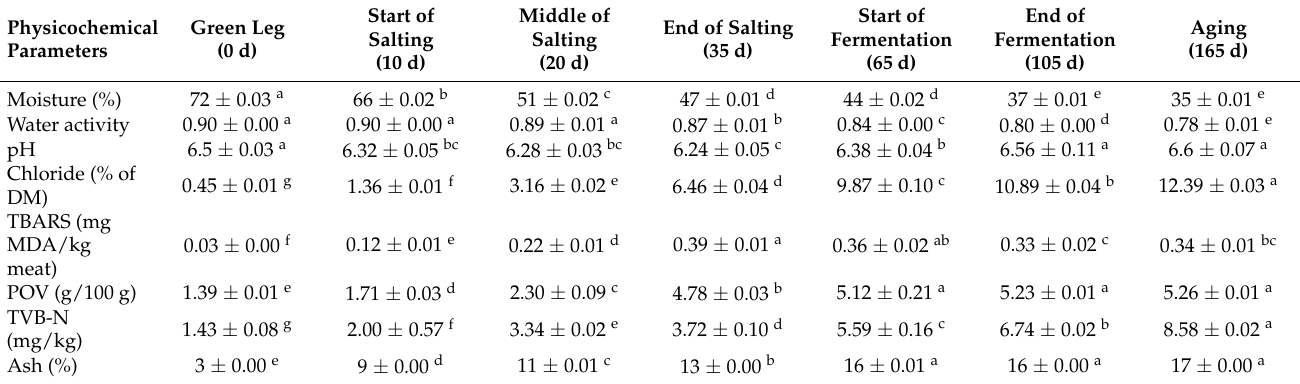
Table 1. Physicochemical parameters during the processing of dry-cured donkey